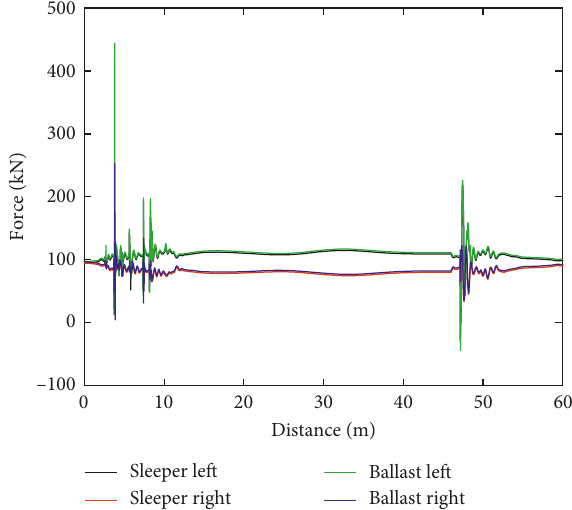
Figure 13: Force exerted on the sleeper and the ballast (moving mass turnout